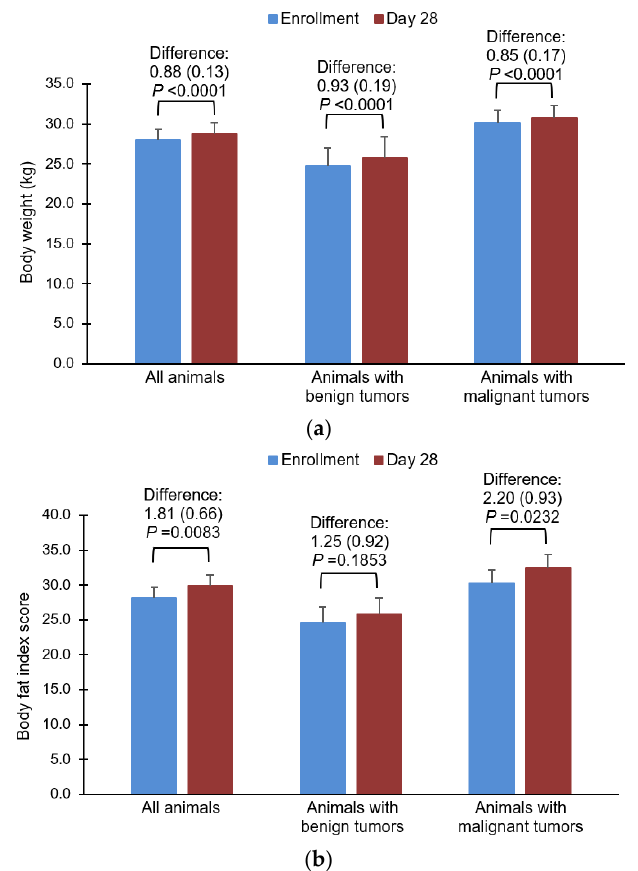
Figure 3. Impact of the food on body weight ( a ), and body fat index score ( b ). Data are represented as means and standard errors.